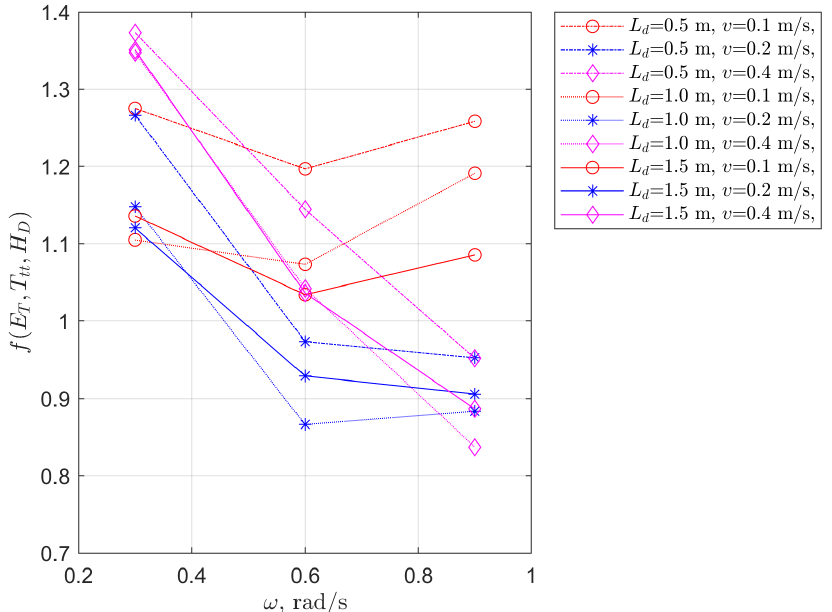
Figure 22. Cost function vs. angular rate for selected maximum values of the linear speed and look ahead distance—track 2.